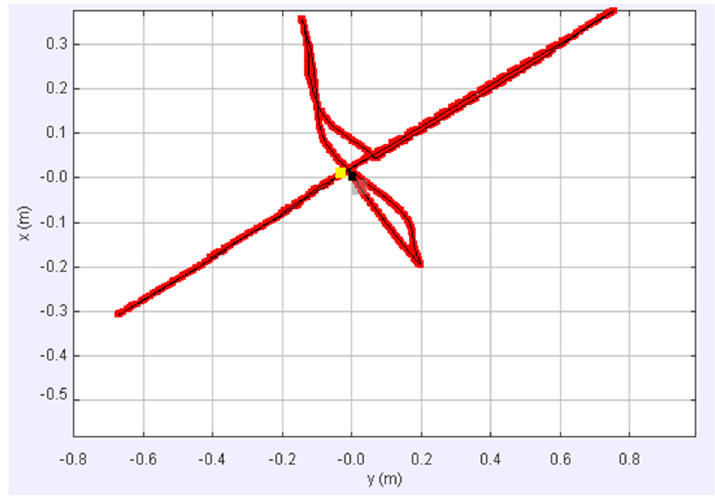
Figure 20. The path in Figure 19 shown by Tracker.